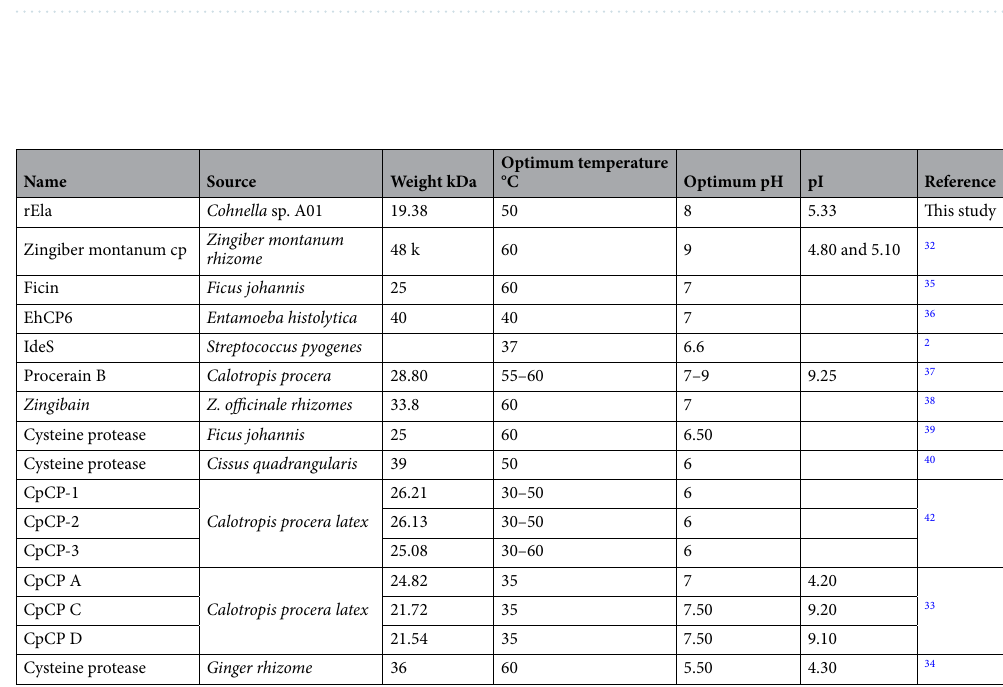
Figure 12. The study of enzyme activity in presence of specific inhibitors ( a ) Leupeptin ( b ) E.64. Leupeptin is a competitive inhibitor which changes k m and E.64 is a uncompetitive inhibitor and changes both k m and v max of the enzyme.